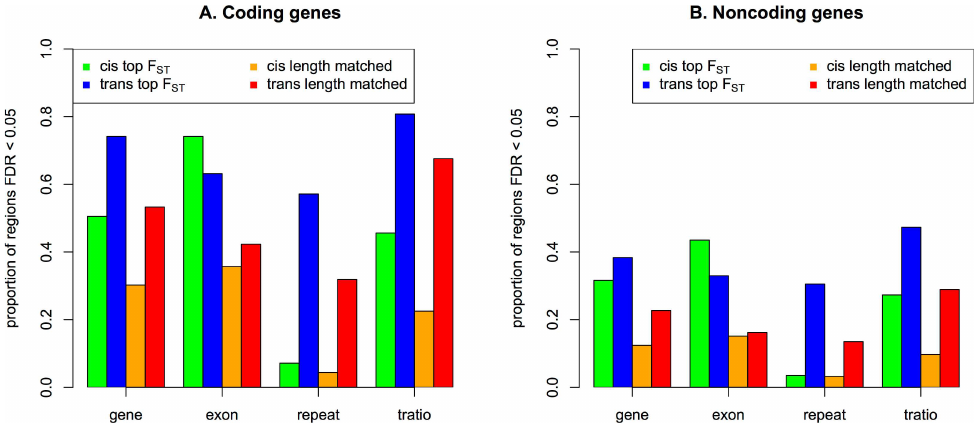
Fig 2. Proportions of regions having eQTLs with FDR < 0.05 among the total regions